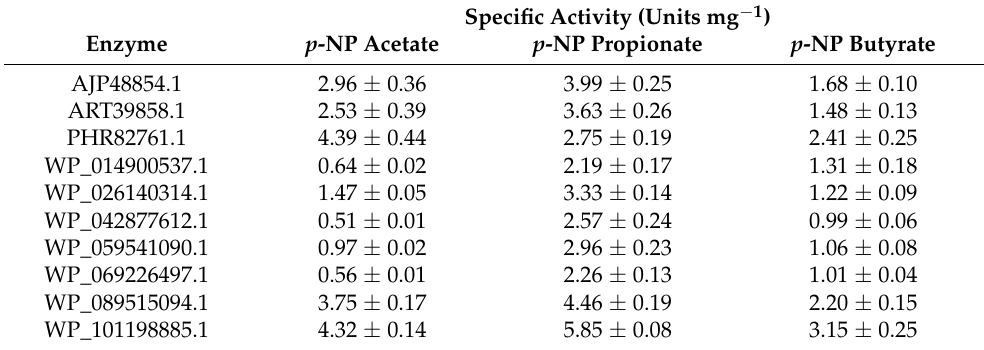
Table 1. Specific activity against p -NP esters. The results are the mean ± SD of triplicates.